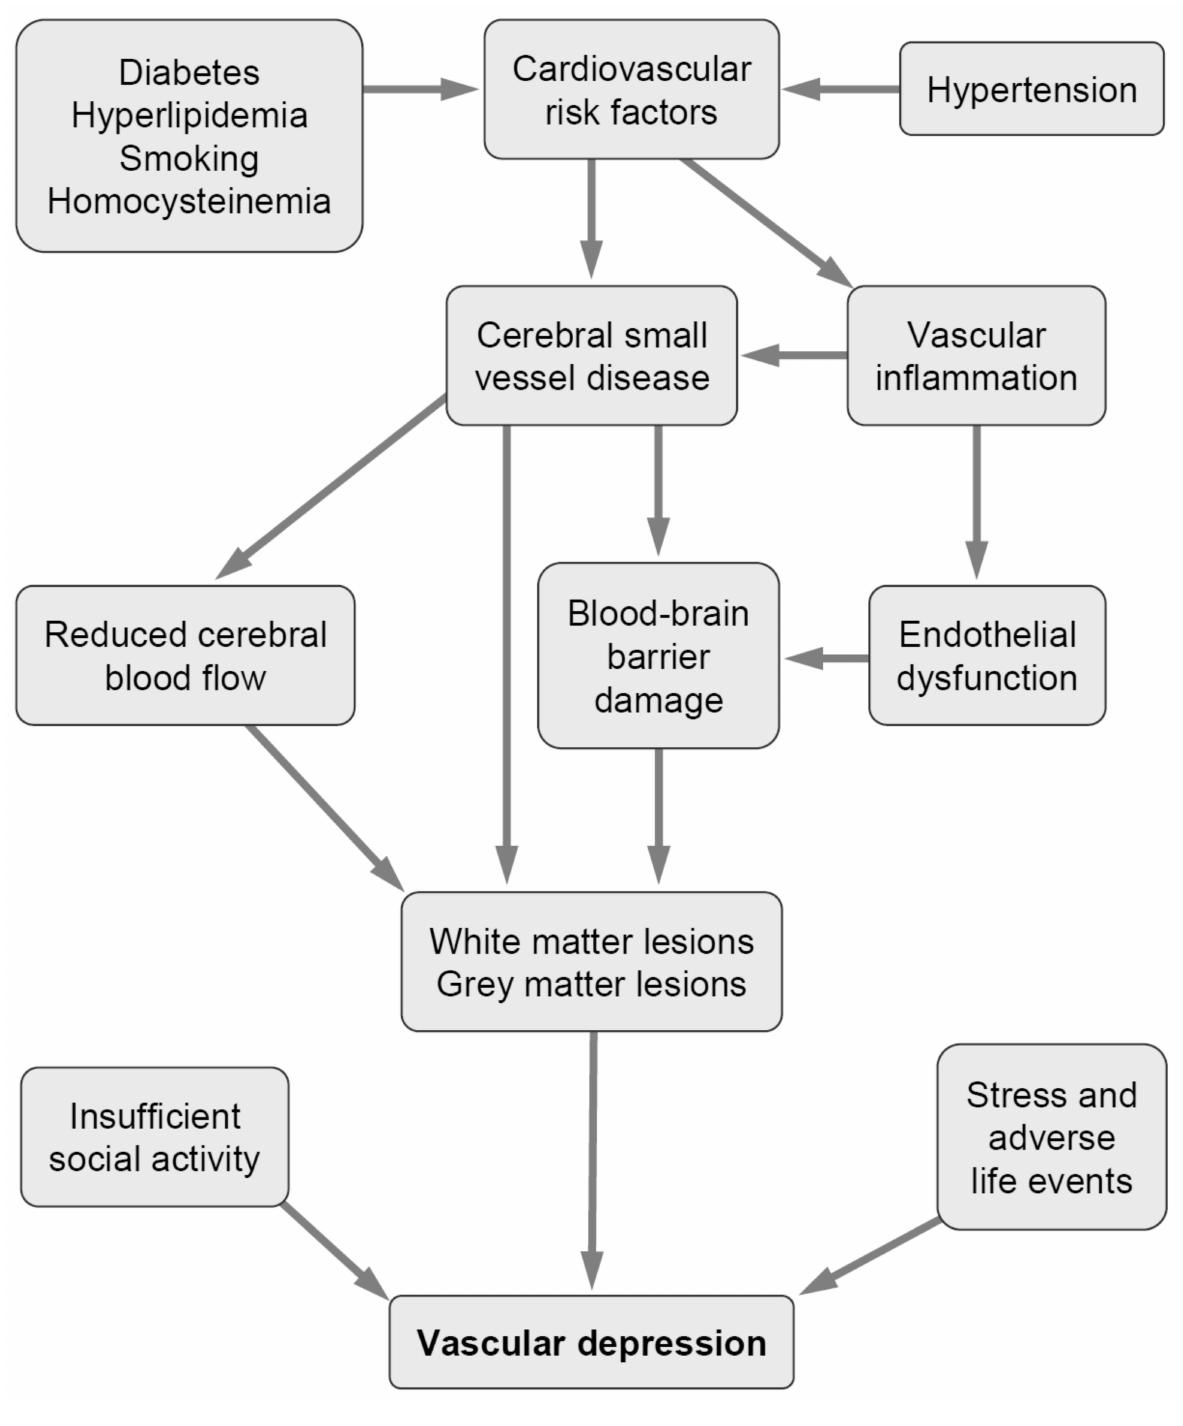
Figure 1. Flow chart of possible mechanisms of vascular